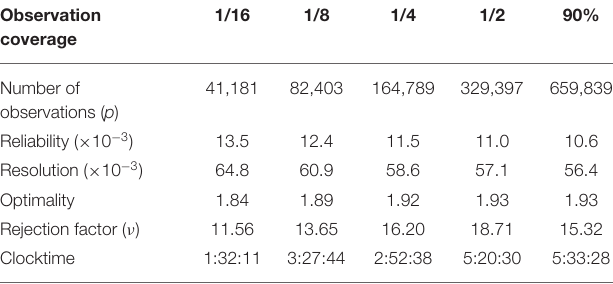
TABLE 2 | Dependence of the solution on observation